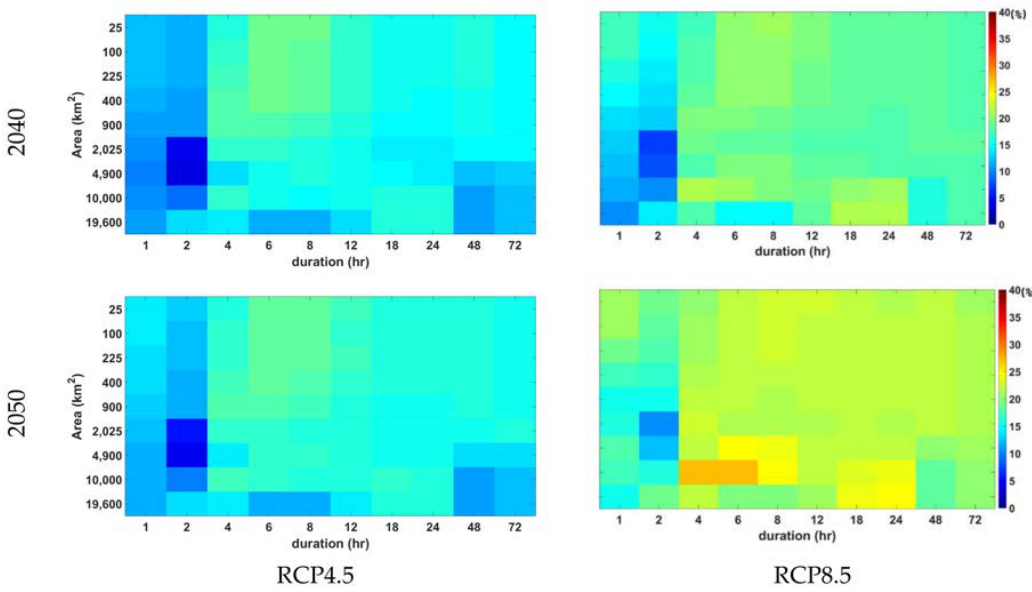
Figure 11. PMPs change rate (%) driven by RegCM-V4.